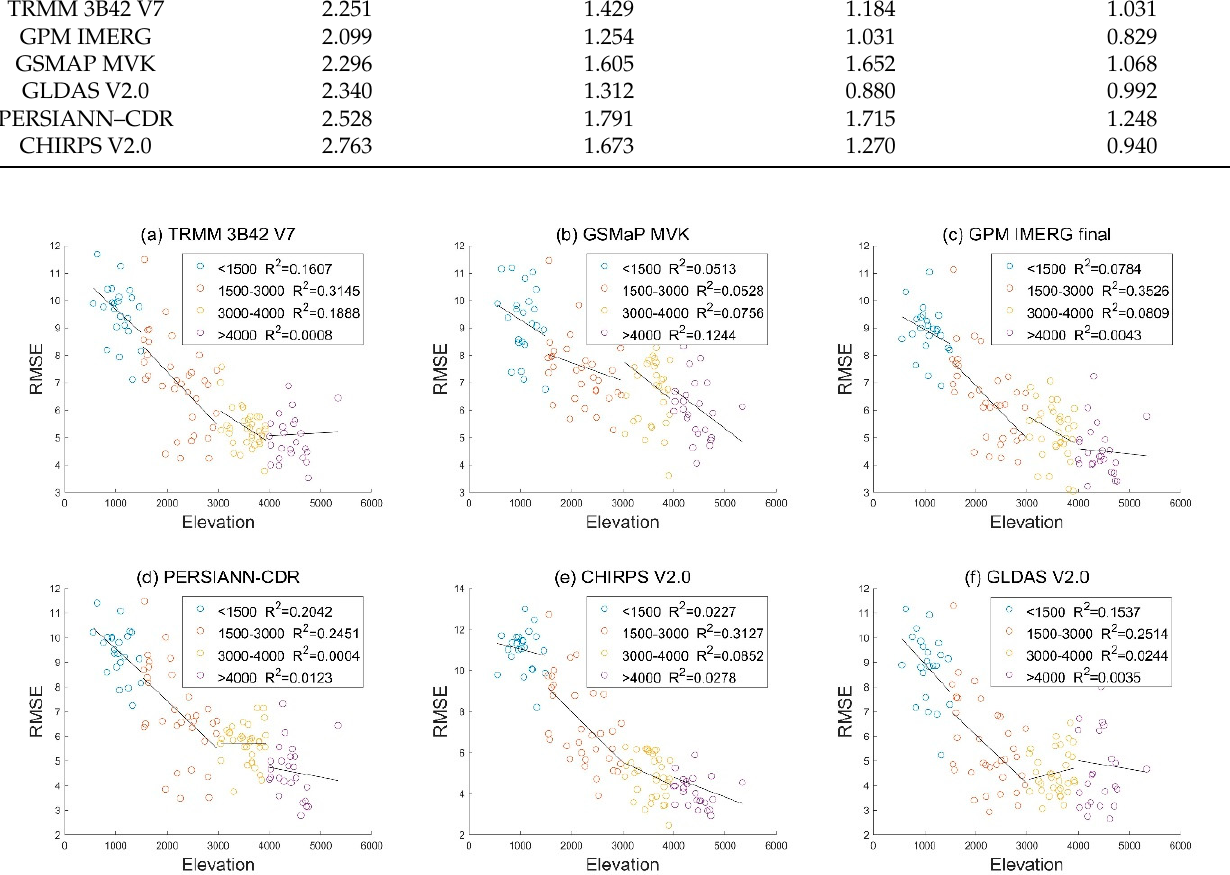
Figure 13. Linear relationship between RMSE and elevation. ( a ) Represents the trend of RMSE and Elevation for TRMM 3B42 V7 data products with elevation changes; ( b ) Represents the trend of RMSE and Elevation for GSMaP MVK data products with elevation changes; ( c ) Represents the trend of RMSE and Elevation for GPM IMERG final data products with elevation changes; ( d ) Represents the trend of RMSE and Elevation for PERSIANN-CDR data products with elevation changes; ( e ) Represents the trend of RMSE and Elevation for CHIRPS V2.0 data products with elevation changes; ( f ) Represents the trend of RMSE and Elevation for GLDAS V2.0 data products with elevation